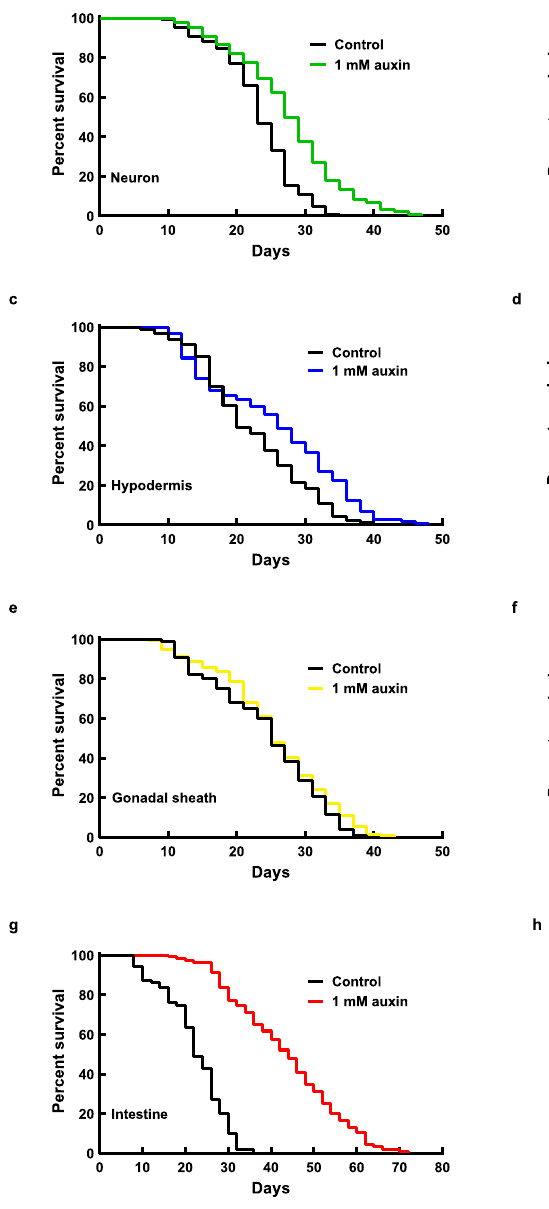
Fig. 3 | Intestine-speci fi c degradation of DAF-2 extended C. elegans lifespan by 94.4%. Degrading DAF-2 in the neurons ( a ), germline ( b ), and hypodermis ( c ) increasedthelifespanby18.6%( p <0.0001),6.4%( p =0.014),and13.7%( p =0.001), respectively. d – f Degrading DAF-2 in the body wall muscle ( d ), gonadal sheath ( e ), or XXX cells ( f ) had no effect on WT lifespan ( p >0.05). g Degrading DAF-2 in the intestine increased WT lifespan by 94.4% ( p <0.0001). h Degrading DAF-2 in the